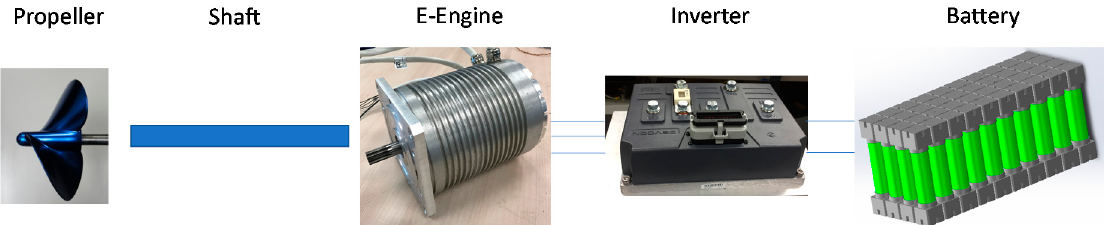
Figure 2. Performance of Honda GX270 engine [7].